Question: Draft a figure caption describing what is shown.
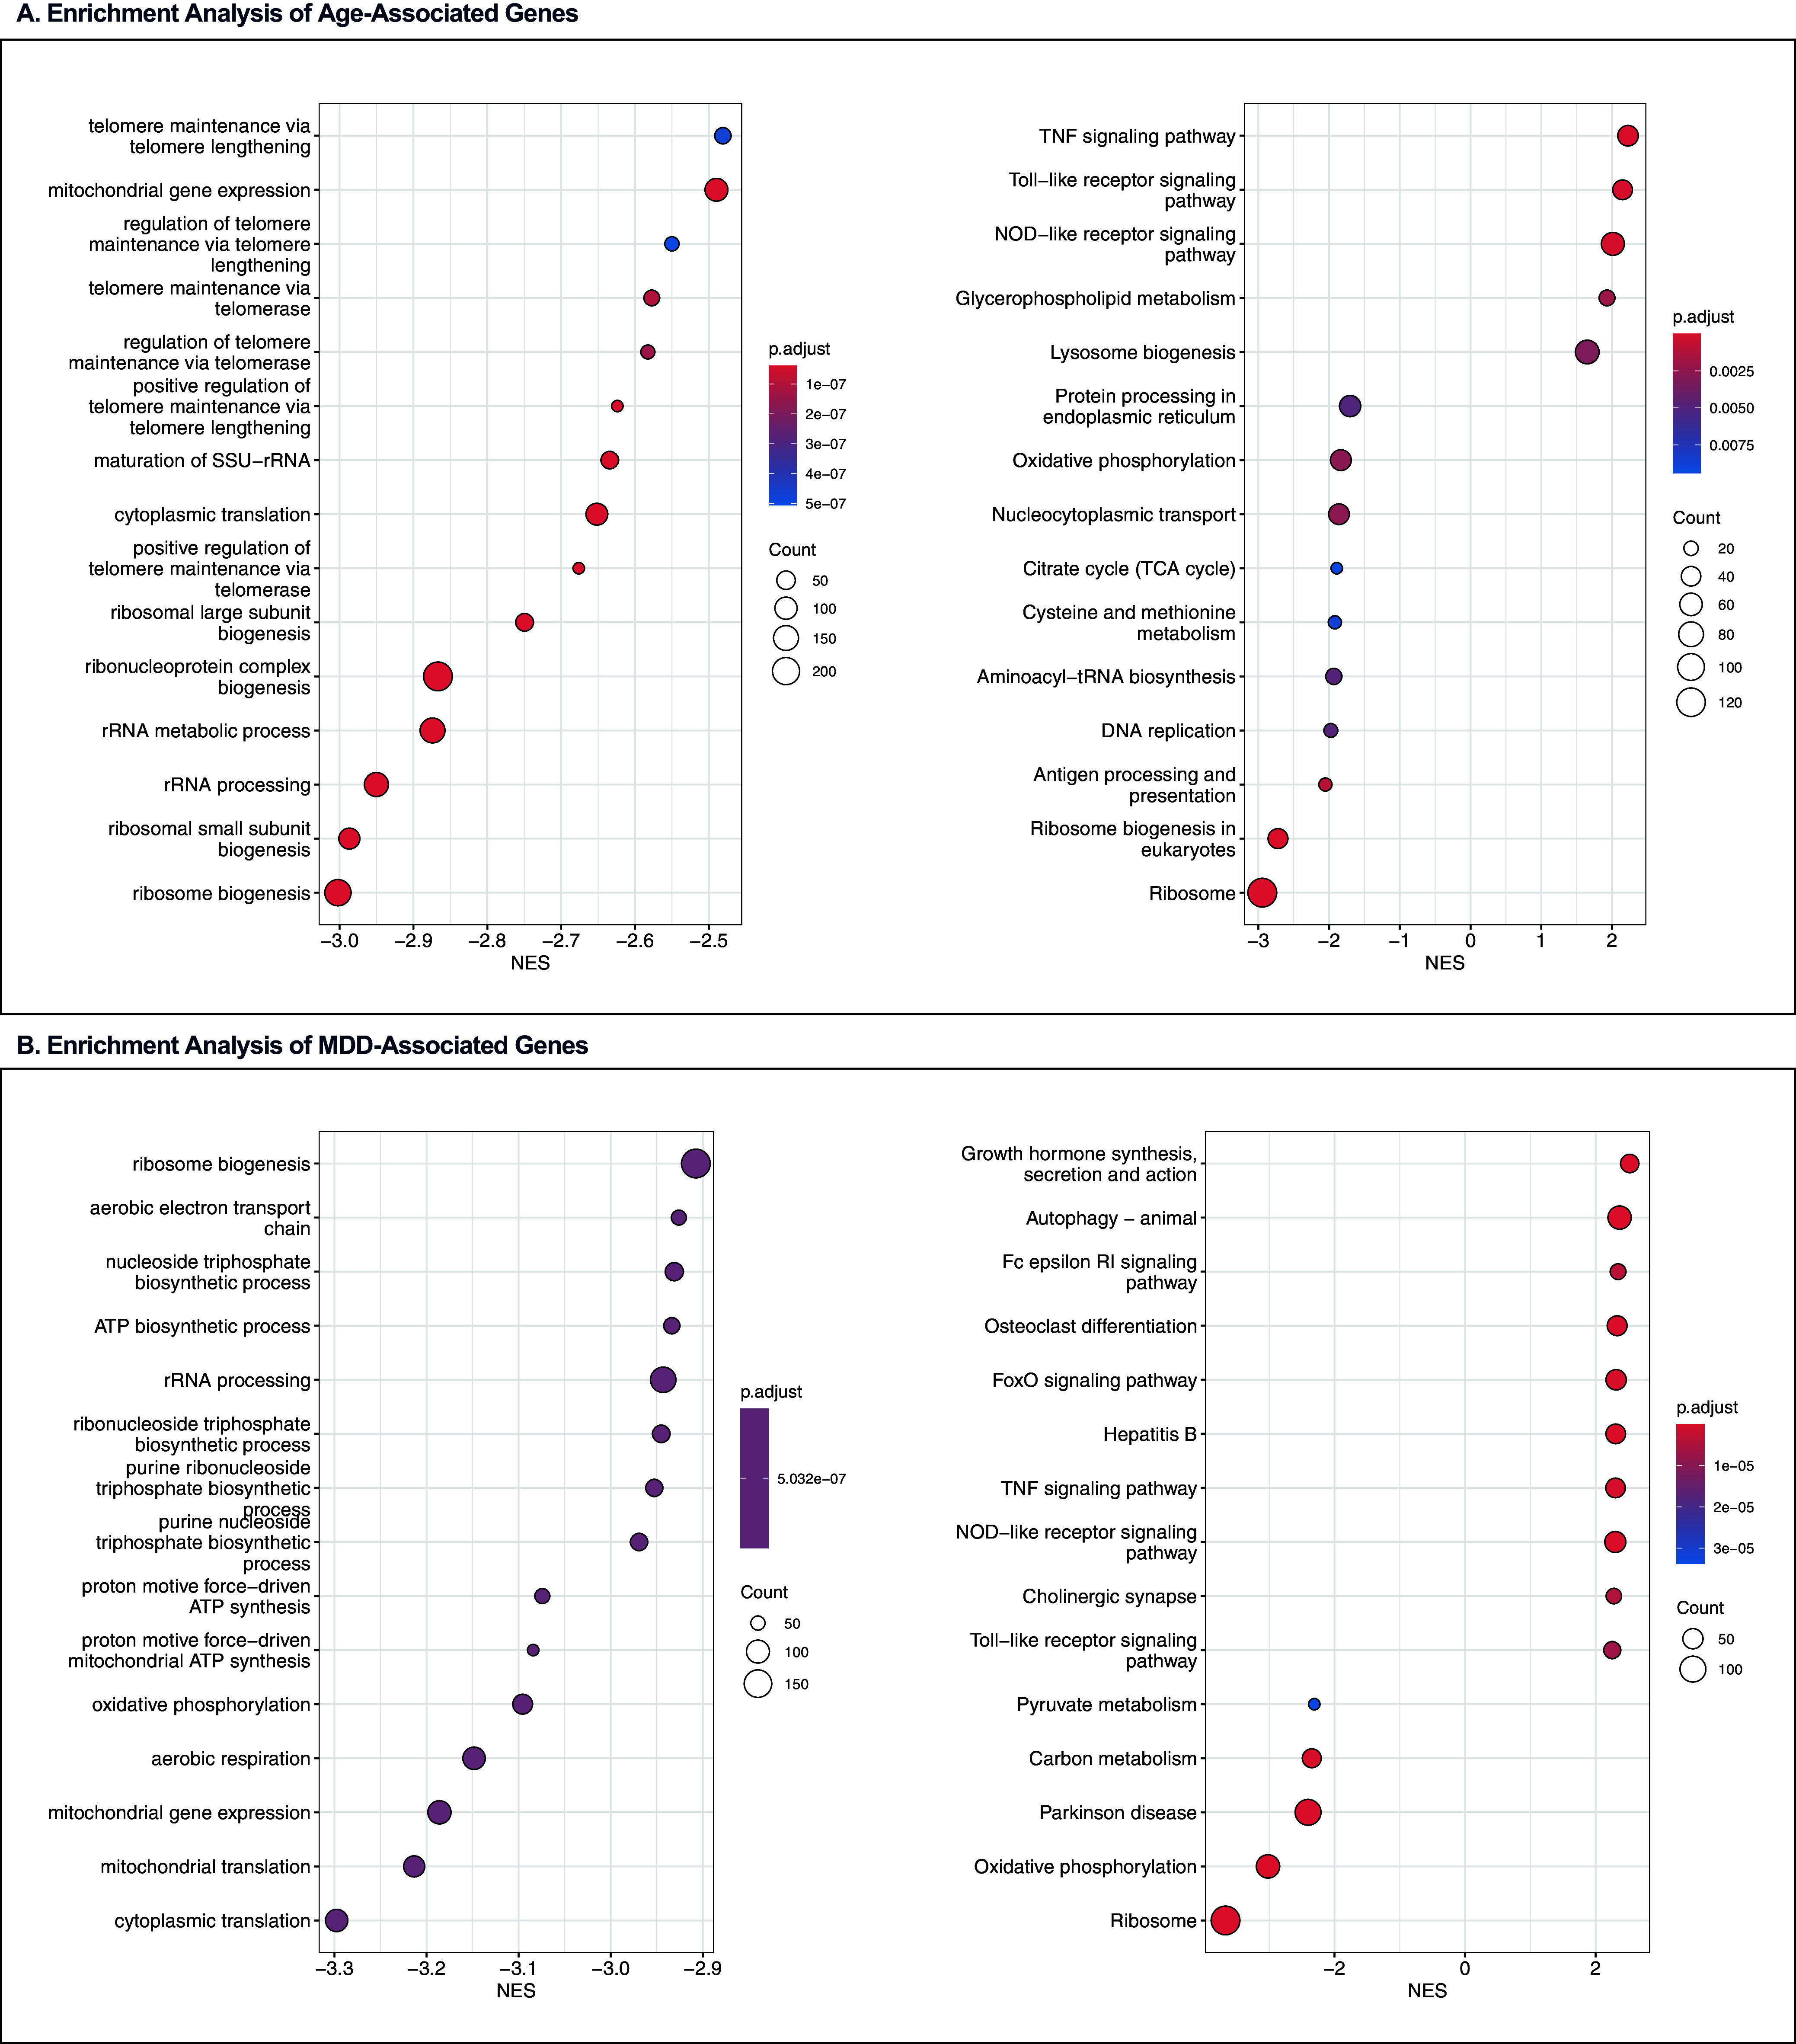
Answer: Gene ontology enrichment and network analysis of significant genes. Note : (a) Enrichment results for aging-associated genes. The left panel shows significantly enriched Gene Ontology biological process terms, and the right panel shows significantly enriched KEGG pathways. (b) Enrichment results for MDD-associated genes. The left panel shows significantly enriched Gene Ontology biological process terms, and the right panel shows significantly enriched KEGG pathways. Abbreviations: NES, ‘normalized enrichment score’. Figure 3. long description.